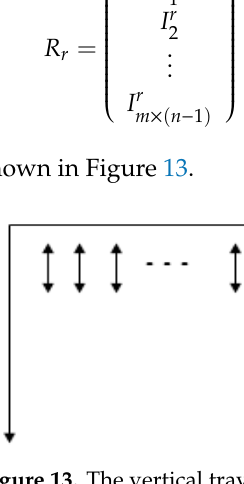
Figure 13. The vertical traversal.